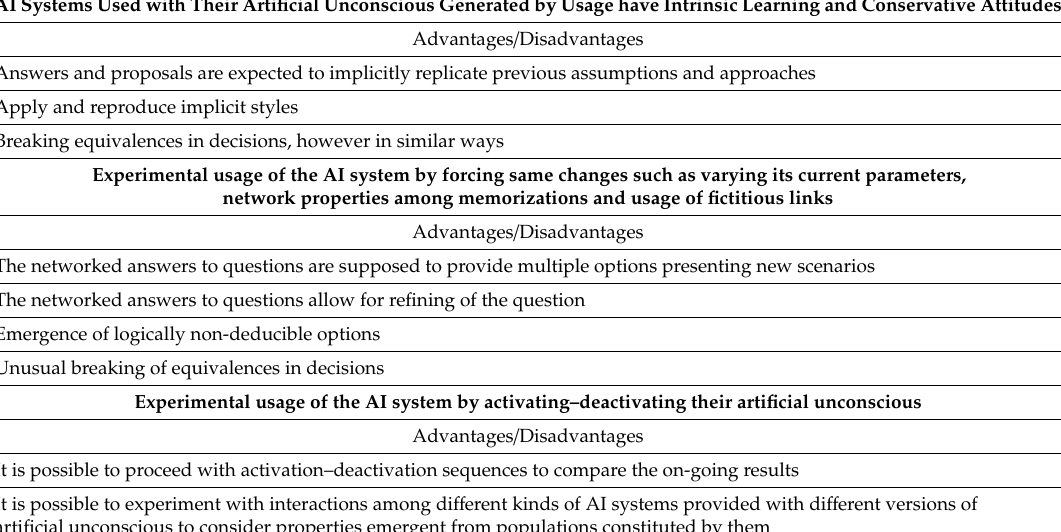
Table 1. A schematic list of advantages and disadvantages of using artificial intelligence (AI) systems equipped with artificial